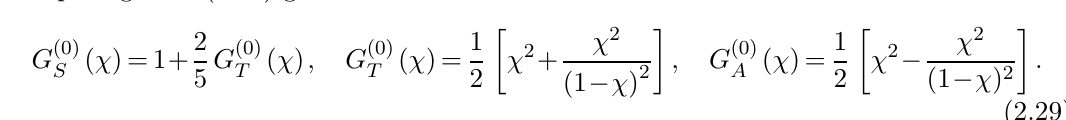
Figure 2 . Contact diagram contributing to (cid:12)rst subleading strong-coupling correction G (1) . Comparing with (2.15)